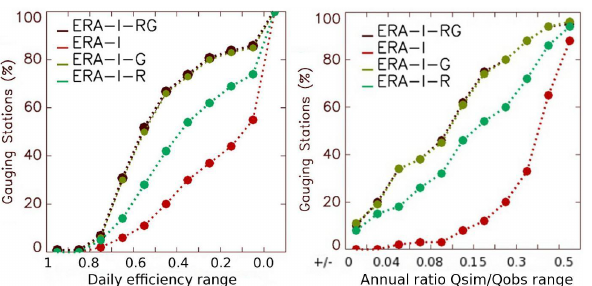
Fig. 5. Cumulative distributions of (left) efficiency and (right) | 1 − Q | values of daily river discharges simulated with sim Q obs the TRIP model. The black, green and red lines represent the NIT-, AST- and STD-TRIP simulations, respectively, driven by the ERA- I-RG precipitation. These distributions are computed from a dense observational network consisting of daily river discharges at 150 gauging stations in the CNF area.